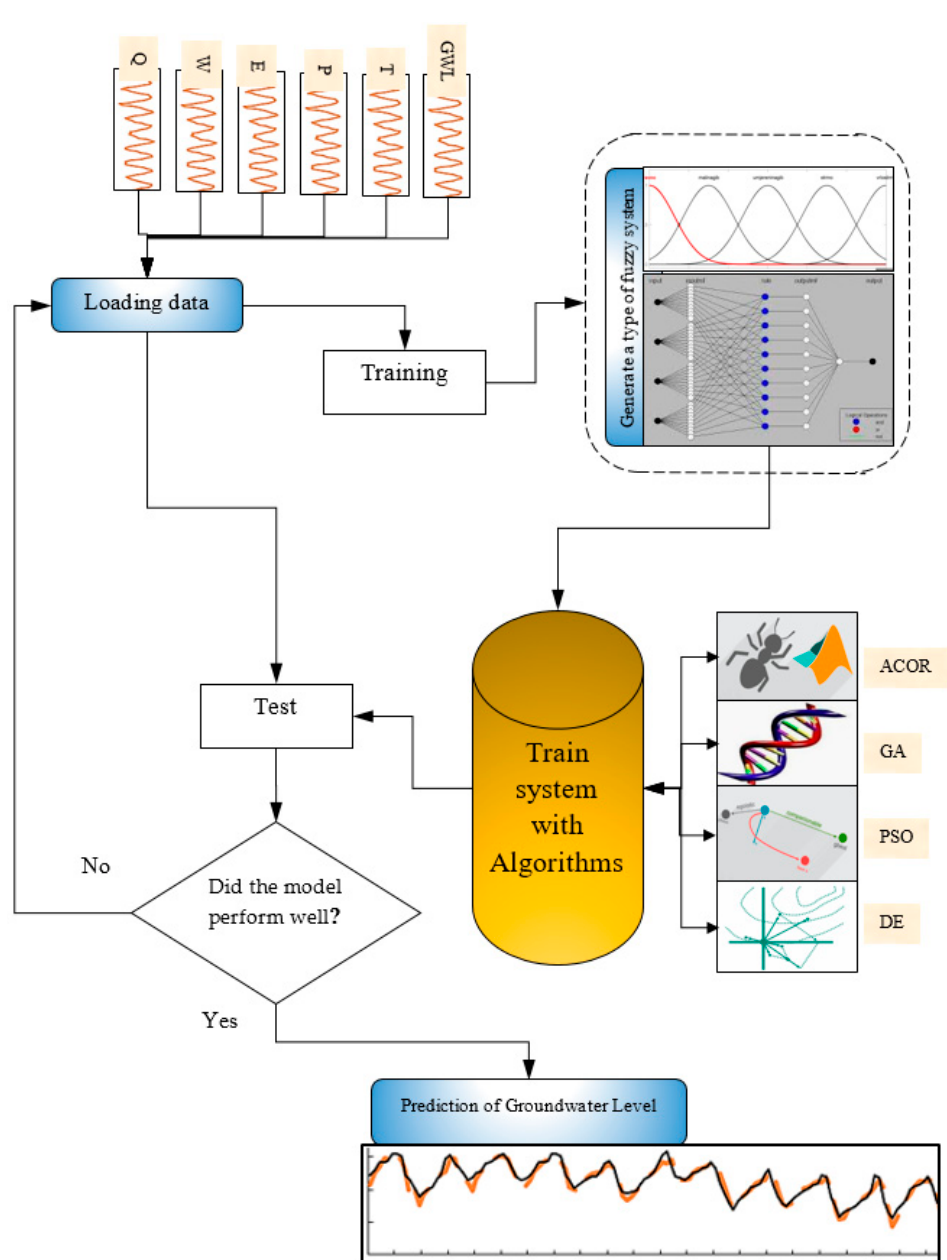
Figure 5. Structure of ANFIS-metaheuristic algorithms hybrid models.